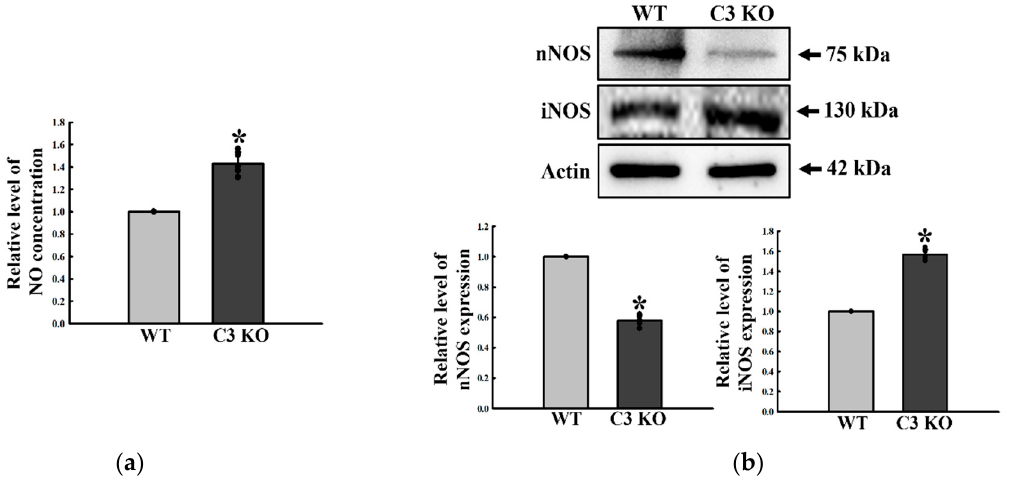
Figure 6. Levels of NO, nNOS, and iNOS in the mid colon of C3 KO mice. ( a ) NO concentration. The concentration of NO was determined using the Griess reagent. Five mice per group were used to prepare the tissue lysates, and the NO concentration was assayed in duplicate for each sample. ( b ) nNOS and iNOS expression. The expression levels of the nNOS and iNOS proteins were determined by Western blot analysis using the specific primary antibody and HRP-labeled anti-rabbit IgG antibody. The band intensities were determined using an imaging densitometer, and protein expressions were calculated relative to the intensity of 𝛽 -actin. Four mice per group were used to prepare the tissue lysates, and Western blots were assayed in duplicate. Data are reported as the mean ± SD. * p < 0.05 compared to the WT mice. Abbreviations: WT, wildtype; KO, knockout; NO, nitric oxide; nNOS, neuronal nitric oxide synthase; iNOS, inducible nitric oxide synthase; HRP, horseradish peroxidase; IgG, immunoglobulin G.